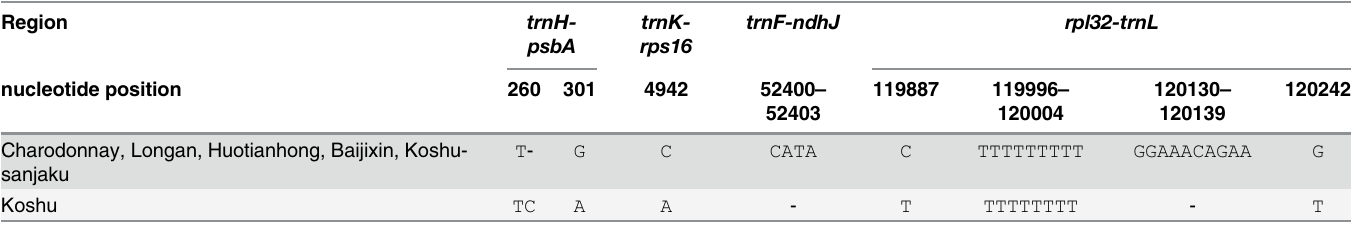
Table 1. Differences in partial sequence of chloroplast DNA between cultivars with V . vinifera type chloroplasts and cultivars with non- V . vinifera type chloroplasts. Nucleotide positions of Maxxa (NC_007957.1) are shown as the reference. trnK- Region trnH- psbA